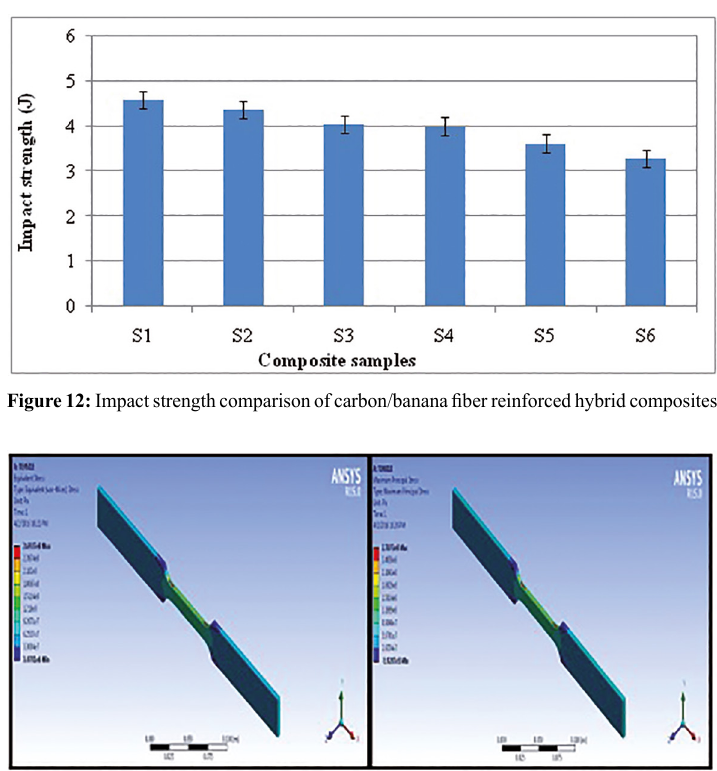
Figure 17. The water intake behavior of the